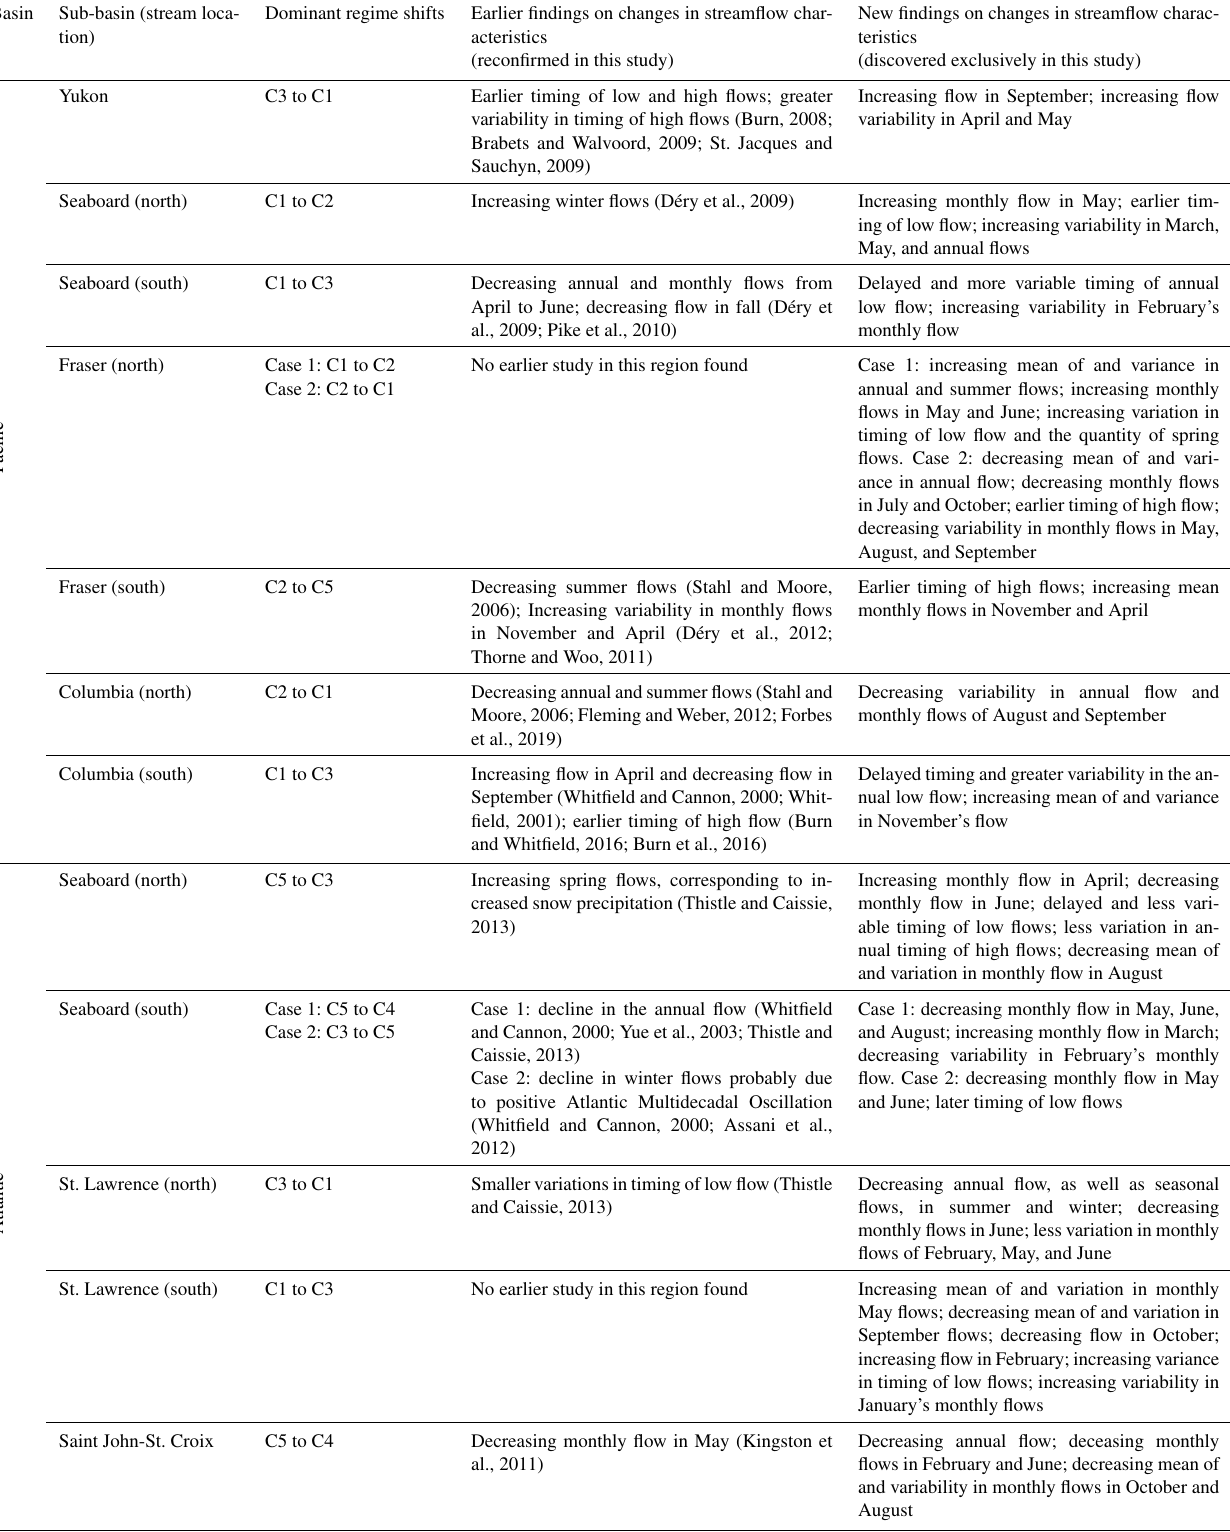
Table 4. Positioning our findings with respect to earlier studies across major Canadian basins and sub-basins.